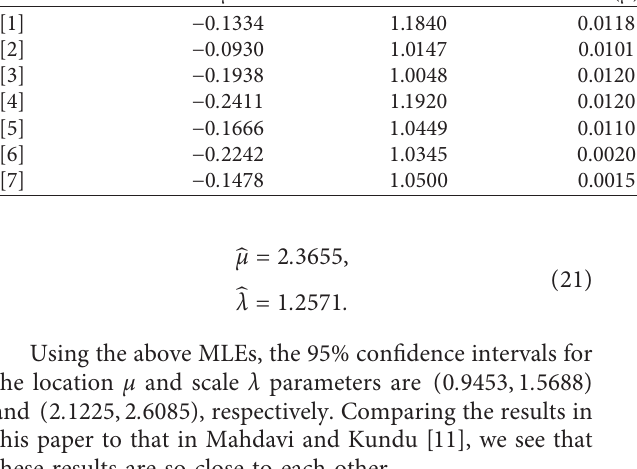
Table 8: MLEs 􏽢 μ , 􏽢 λ , biases, and MSEs for μ and λ from APE distribution when α � 3 . 5.